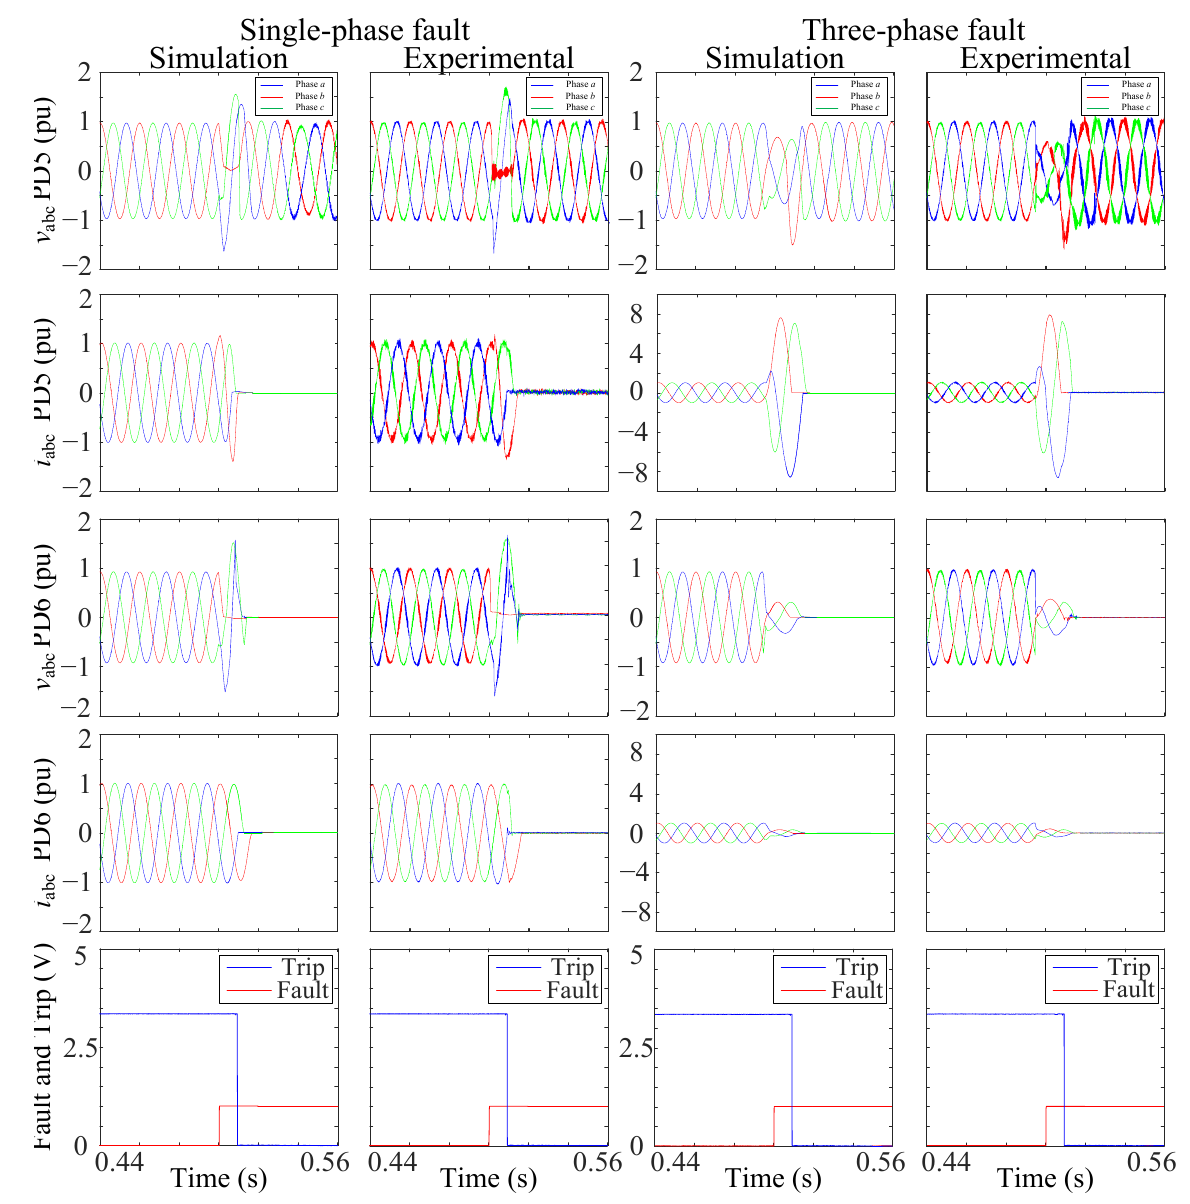
Figure 11. Simulation and experimental abc voltages and currents of PD5, PD6, and trip signals of the CE-ZO algorithm decision in the case of a three-phase fault, and a single-phase at F2.